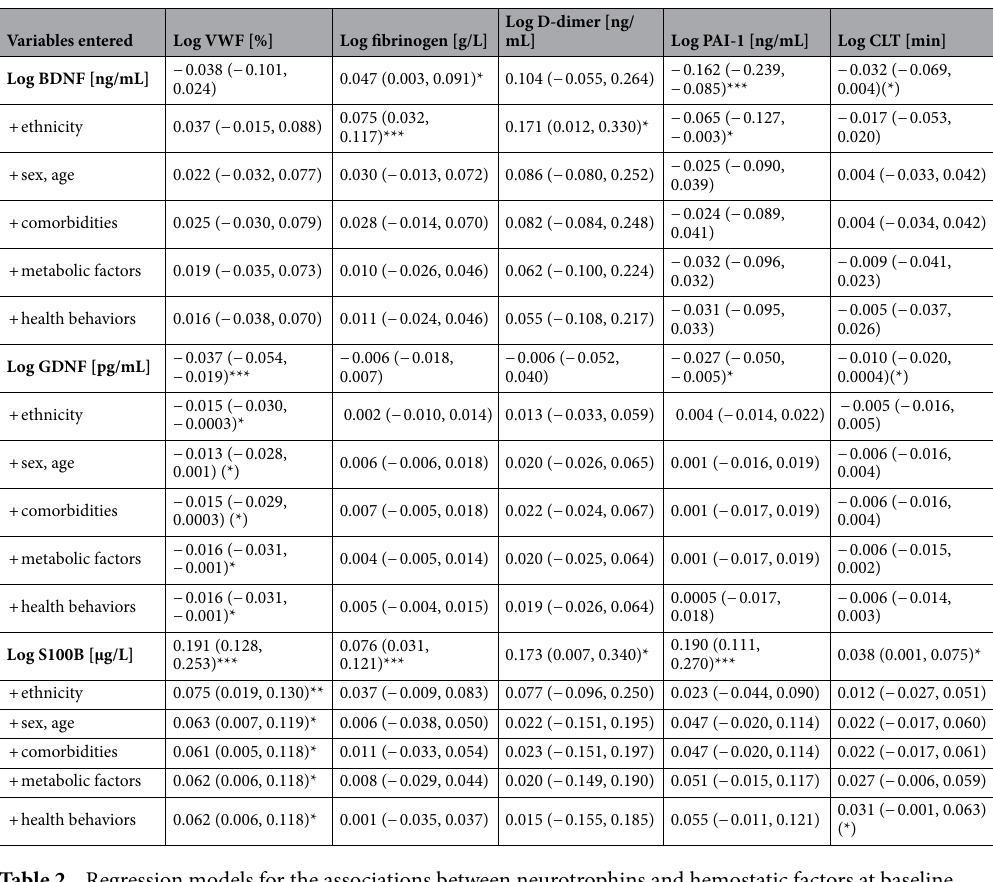
line to stress in all participants. GDNF reactivity was significantly greater in whites, whereas S100B reactivity was significantly greater in blacks compared with their respective ethnic counterparts. After outlier values had been removed, median (range) for stress-induced percent changes were − 1.2% (− 67.1–58.3) for GDNF, 0.6% (− 21.0–21.3) for S100B, 4.0% (− 15.3–34.3) for VWF, − 6.9% (− 49.6–22.7) for fibrinogen and 0.7% (− 53.2–59.9) for D-dimer. Neurotrophins at baseline and hemostatic factors in response to stress. The regressions of base-